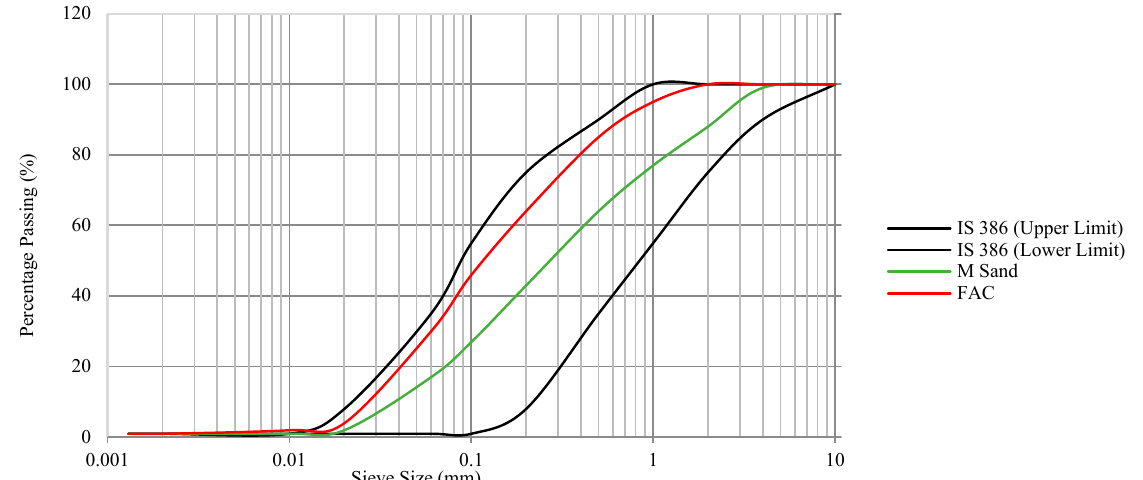
Figure 3. Particle Size Distribution Curve. Table 2. Mix Proportion.